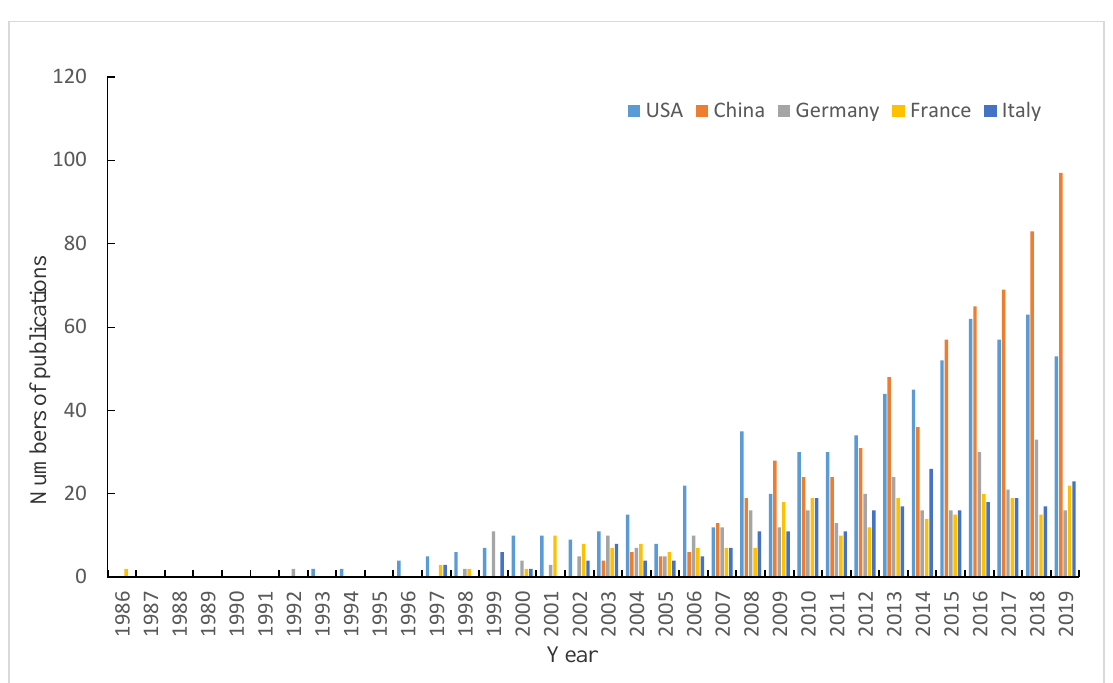
Figure 3. Trends in the number of published articles in the top 5 countries from 1986 to 2019.